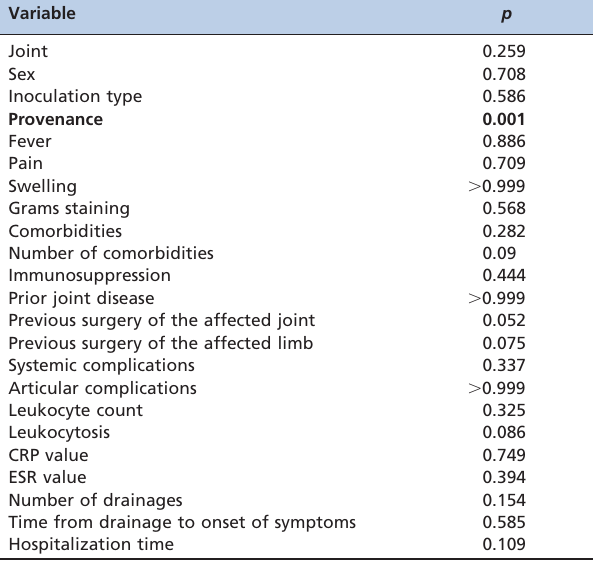
Table 2 - Statistical